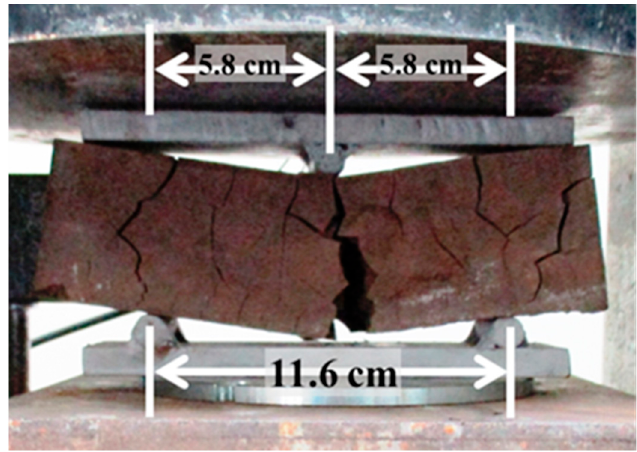
Figure 4. Three-point flexural strength test.